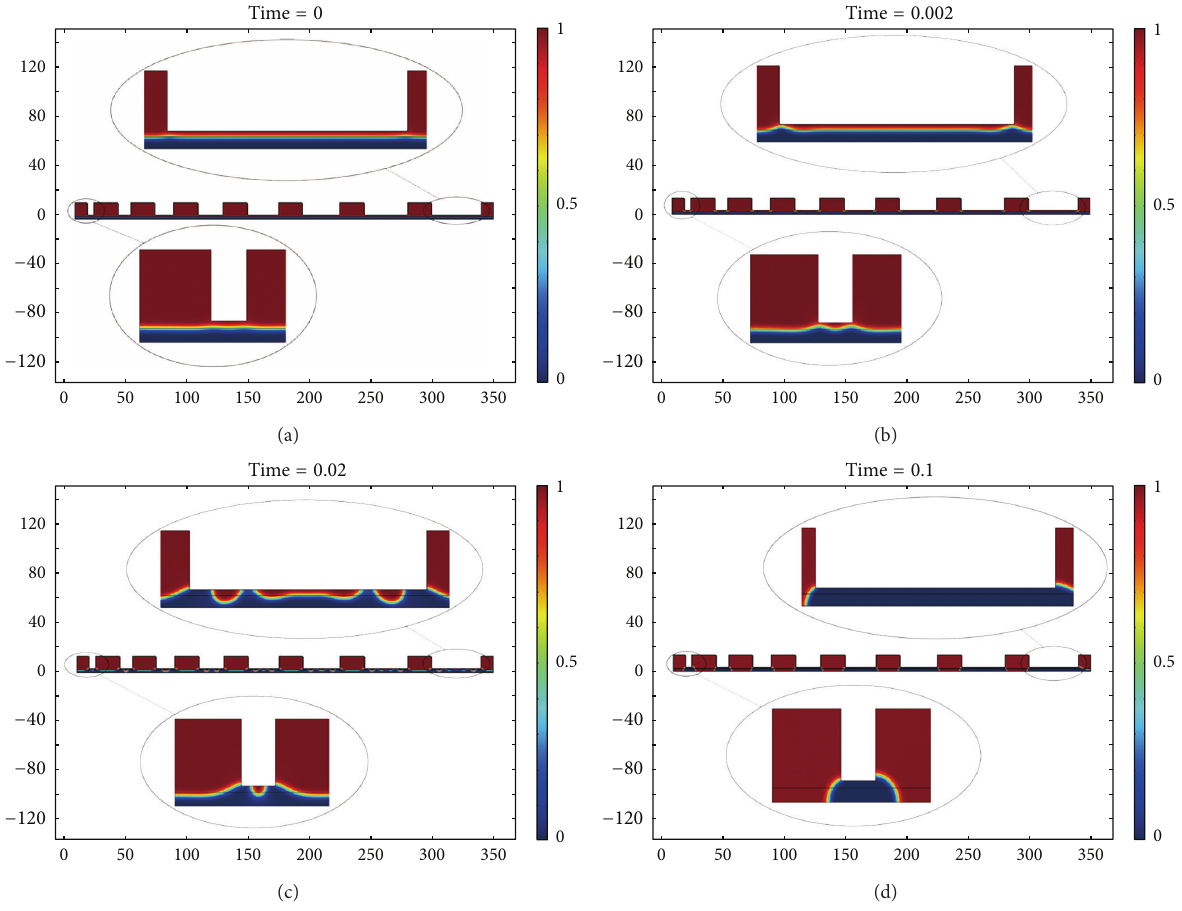
Figure 6: The evolution process of EHD patterning experiment with the lowest spacer (3.0 𝜇 m). (a) The initial stage of EHD patterning, (b) and (c) the evolutionary stage of EHD patterning, and (d) the final stage of EHD